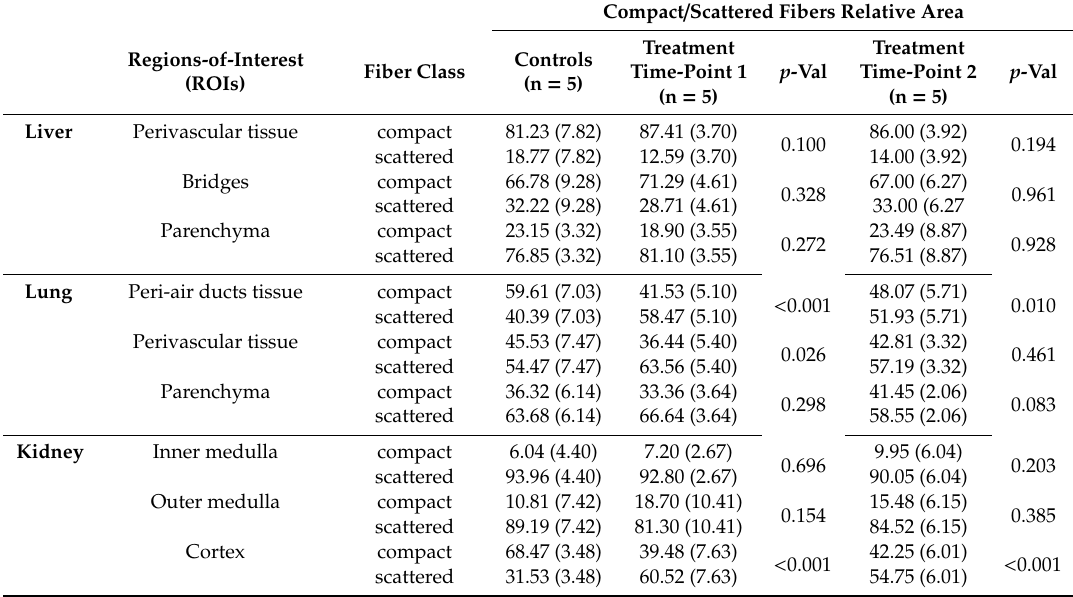
Table 5. Collagen proportion (%) per fiber type in specific histological compartments. Mean percentages ( ±